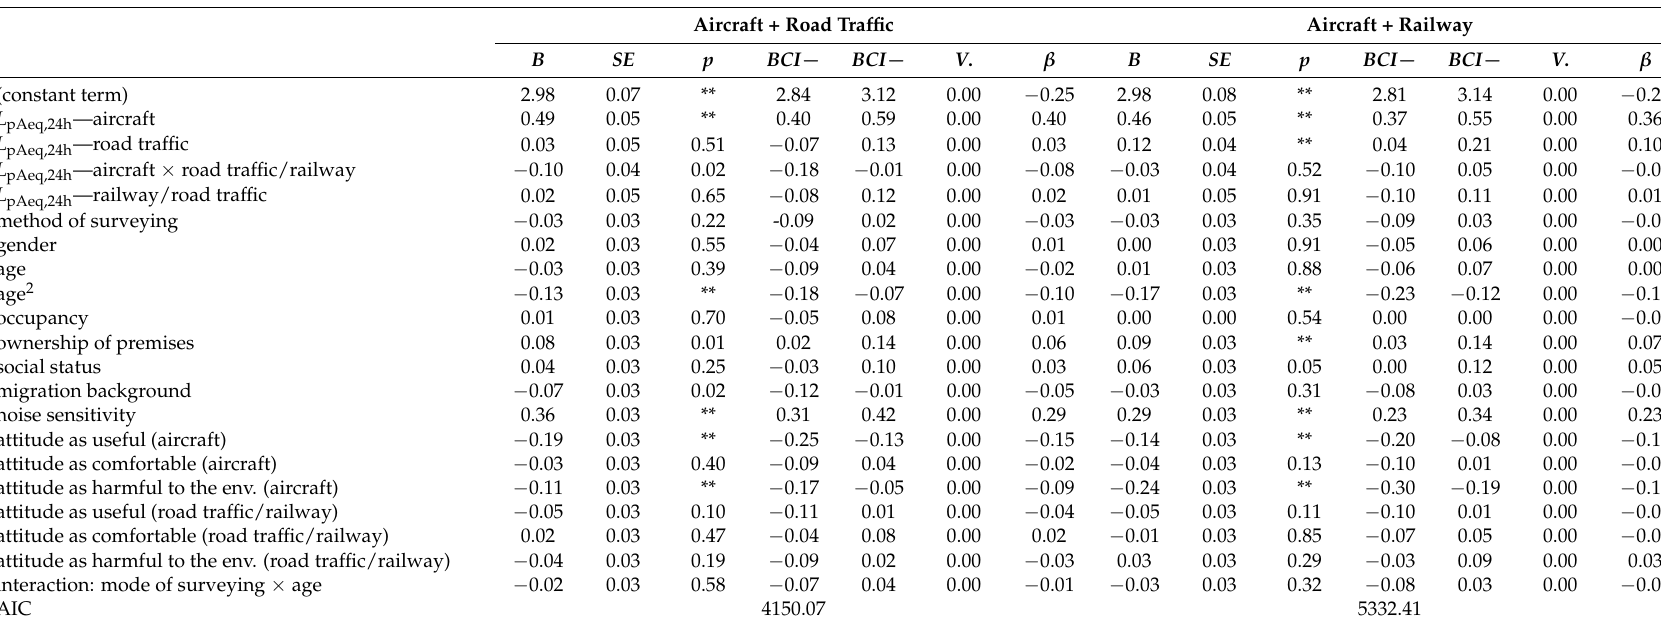
Table 7. Results of the multiple linear regression analysis of the impact of aircraft + road traffic noise and aircraft + railway noise on the total noise annoyance. Aircraft + Road Traffic Aircraft +